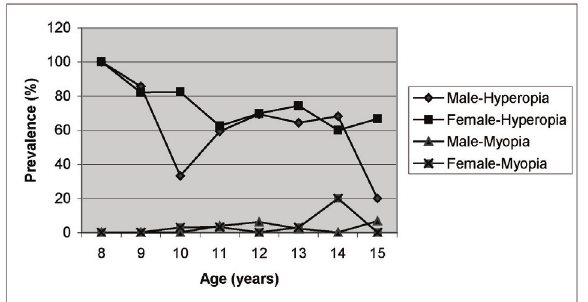
Figure 3 Graphical representation of the prevalence of refrac- tive powers by age in the left eyes of the male and female sub- jects. Hyperopia was more prevalent in both genders.